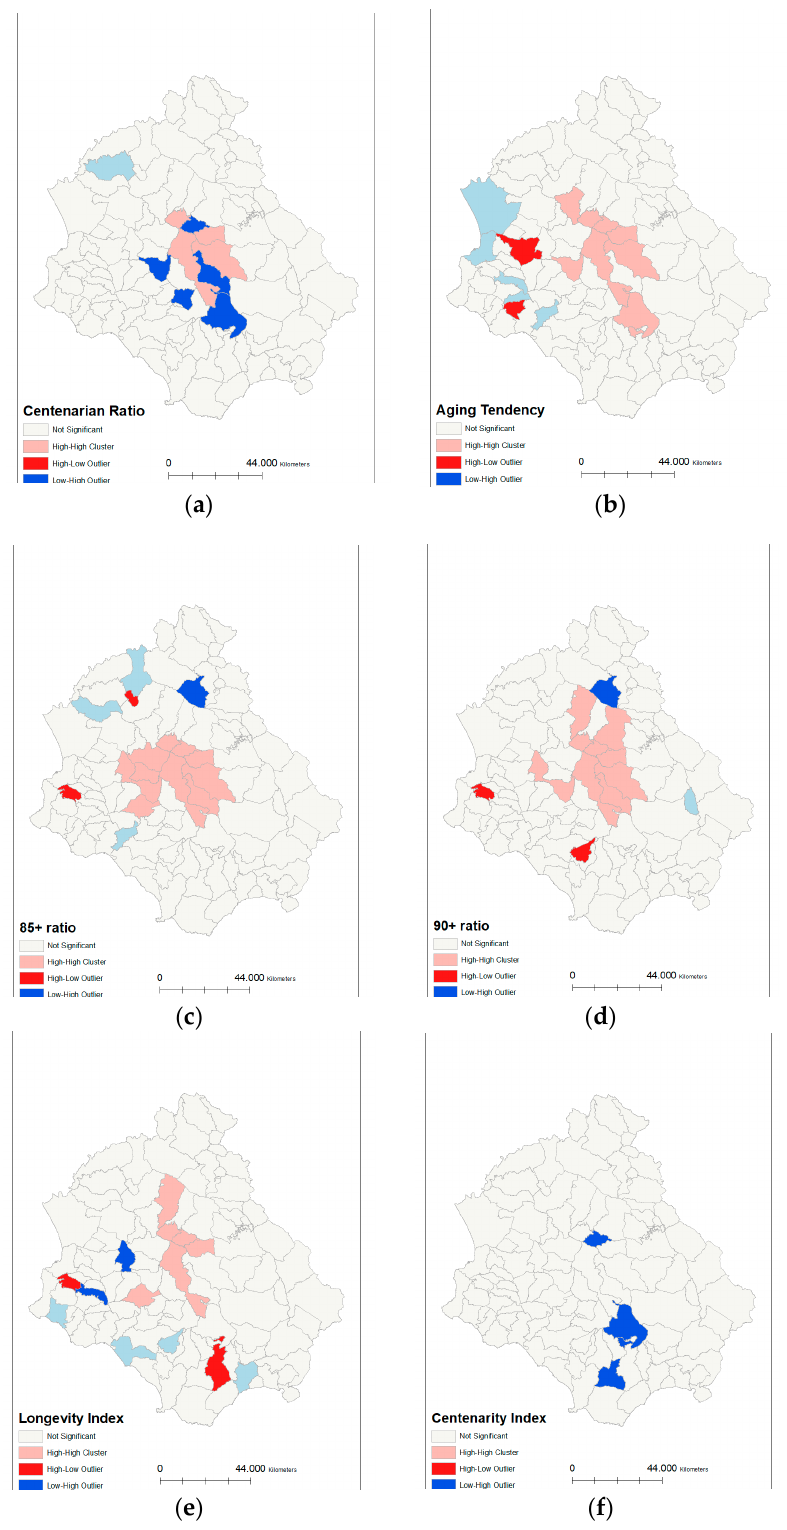
Figure 3 . Local spatial distribution (Anselin local Moran’s I) maps of the cluster/outlier type for longevity indicators in Cilento municipalities. Note: ( a ) maps of the cluster/outlier type for Cente- narian ratio; ( b ) maps of the cluster/outlier type for Aging tendency; ( c ) maps of the cluster/outlier type for 85+ ratio; ( d ) maps of the cluster/outlier type for 90+ ratio; ( e ) maps of the cluster/outlier type for Longevity index; ( f ) maps of the cluster/outlier type for Centenarity index .